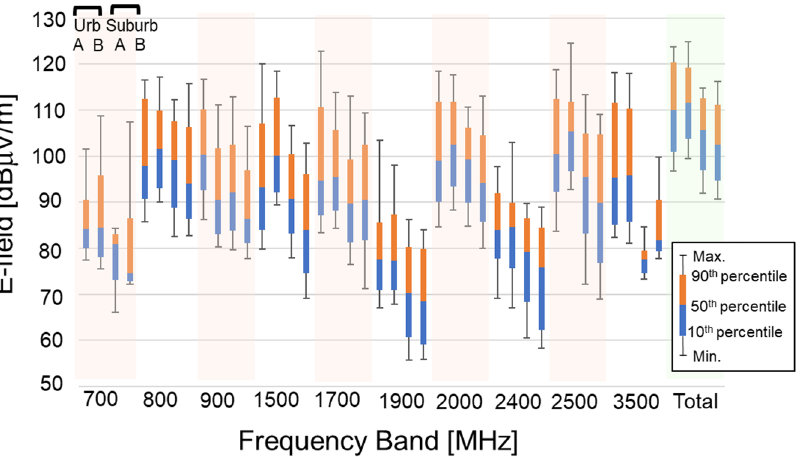
Figure 3. Statistical distribution of E-field strength in each frequency band and total frequency bands in the outdoor environments.